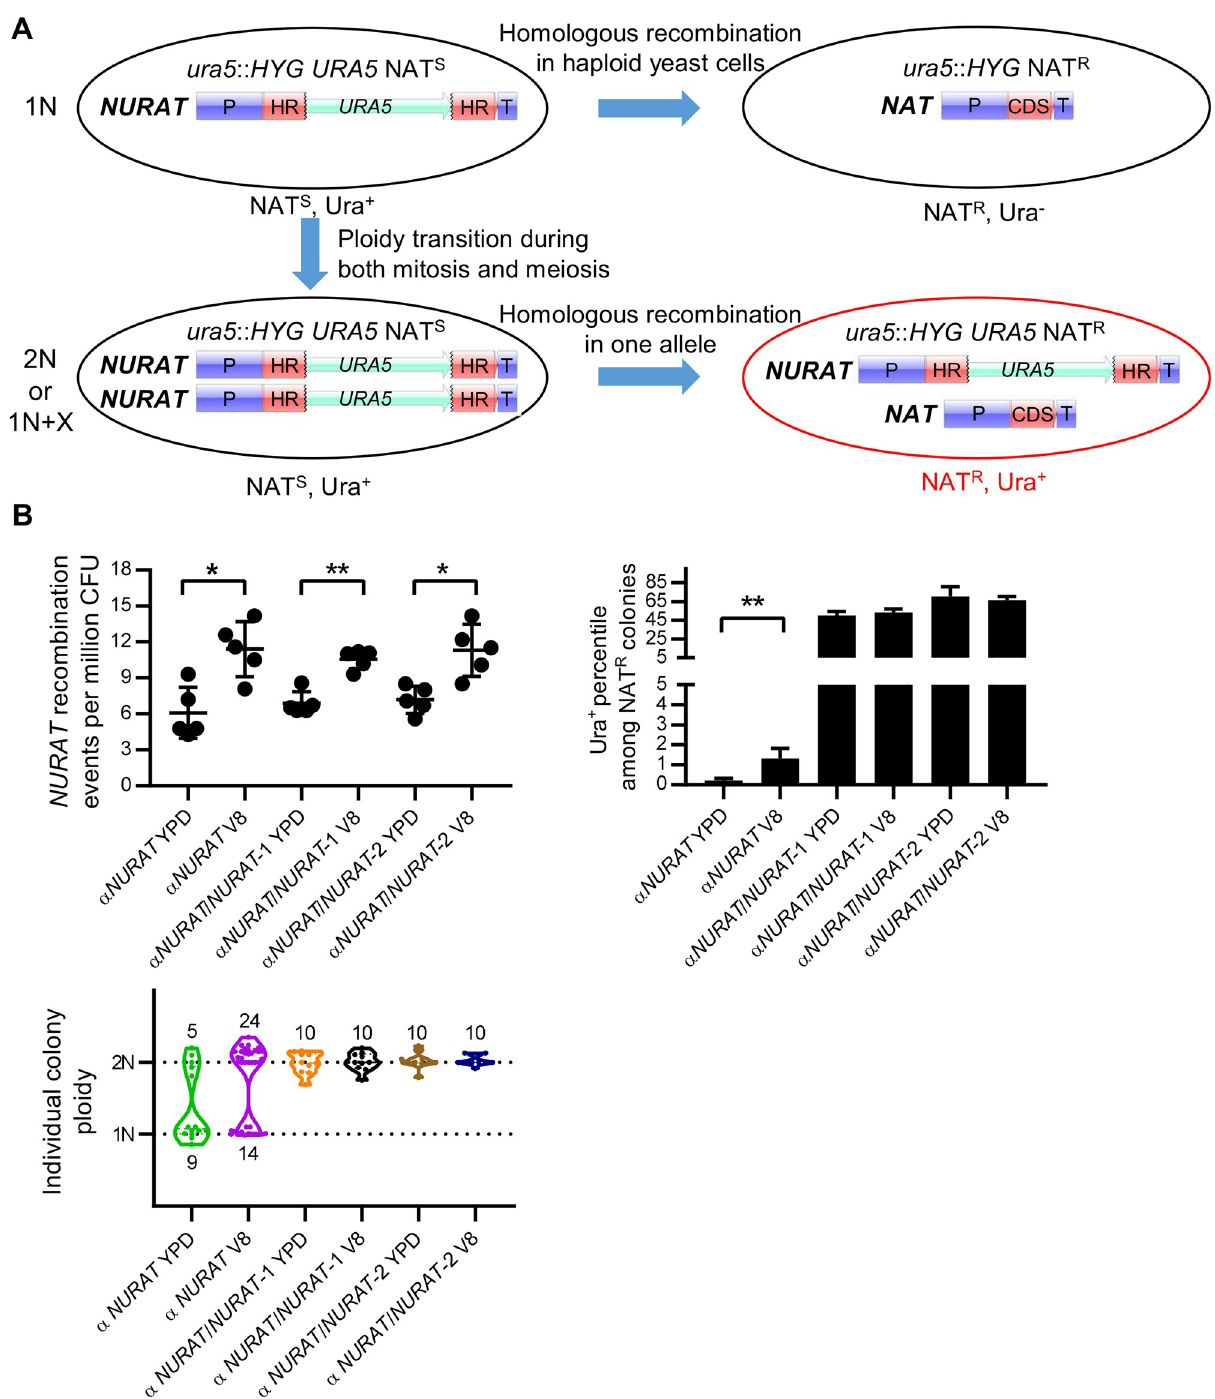
Fig 3. Ploidy sensor reports ploidy transition events during both mitotic and meiotic growth. (A) Schematic diagram shows that the mechanism by which the ploidy sensor construct NURAT detects ploidy transition depends on homologous recombination in one NURAT allele after the ploidy transition events. (B) A haploid and two diploid ura5 Δ strains harboring NURAT constructs were incubated on YPD and V8 agar medium for 60 hours. The number of NURAT recombination events per million CFU was plotted to compare the recombination frequencies. NAT R colonies were replica- plated onto SD-URA agar medium to obtain cells that contain both NURAT and NAT constructs. The percentile of NURAT presence among NAT R colonies were plotted in the bar graph. Mean values of five independent experiments were plotted for the NURAT recombination frequencies and the Ura + percentiles among NAT R colonies; error bars represent standard deviations. � indicates 0.01 < p � 0.05 and �� indicates 0.001 < p � 0.01. Individual NAT / NURAT colonies were tested for ploidy by FACS and plotted in the violin